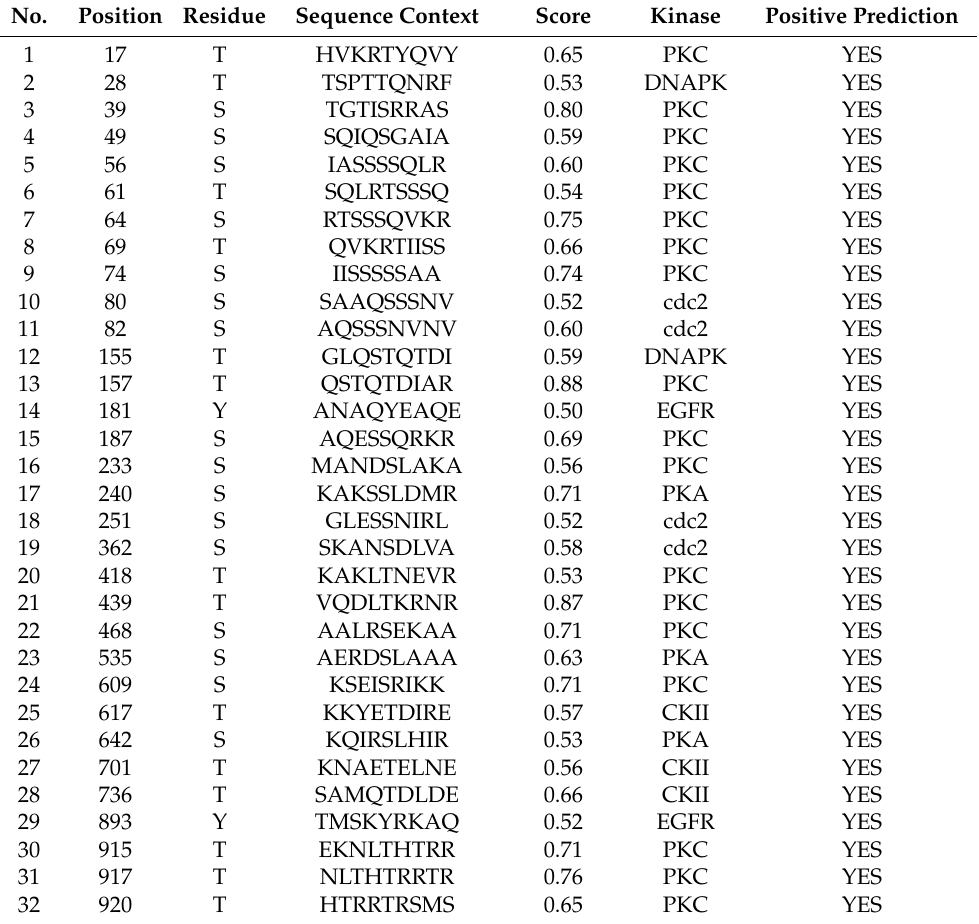
Table 2. The phosphorylation sites identified in paramyosin of Patinopecten yessoensis